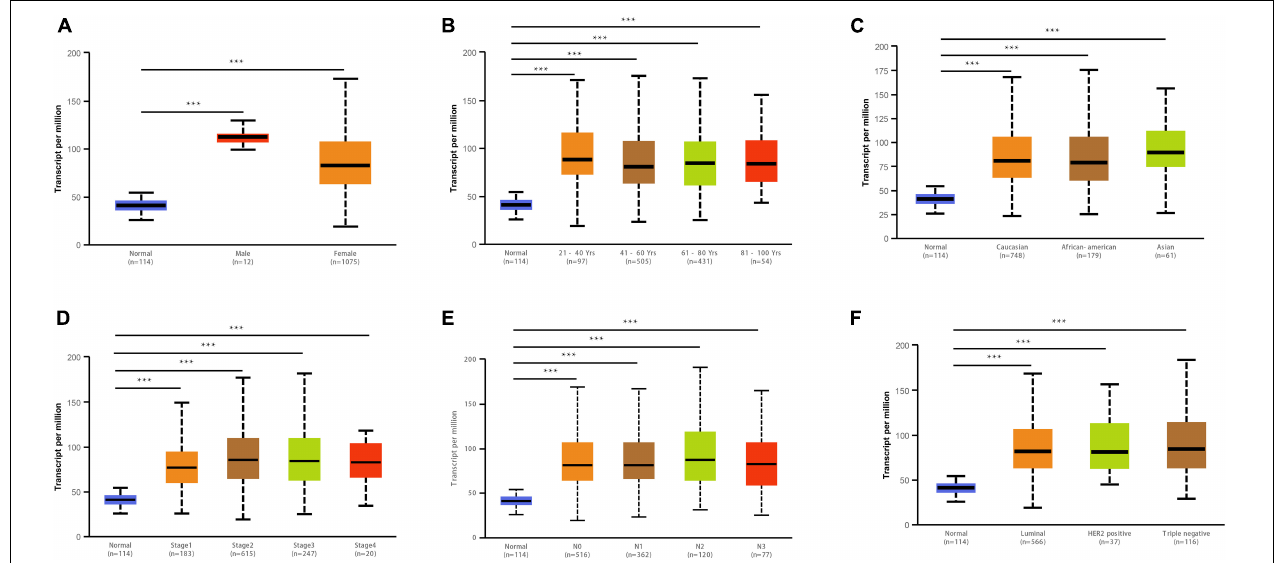
FIGURE 3 | TIMM17A transcription in breast cancer (BRCA) patient subgroups stratified by sex, age, ethnicity, cancer stage, and metastasis (UALCAN). (A) Boxplot showing relative expression of TIMM17A in normal individuals of either sex and separately for male and female BRCA patients. (B) Boxplot showing relative expression of TIMM17A in normal individuals of any age and separately for BRCA patients aged 21–40, 41–60, 61–80, or 81–100 years. (C) Boxplot showing relative expression of TIMM17A in normal individuals of any ethnicity and separately for BRCA patients of Caucasian, African-American, or Asian ethnicity. (D) Boxplot showing relative expression of TIMM17A in normal individuals and separately for BRCA patients in stages 1, 2, 3, or 4. (E) Boxplot showing relative expression of TIMM17A in normal individuals and separately for BRCA patients with regional lymph node metastasis N0, N1, N2, or N3 tumors. (F) Boxplot showing relative expression of TIMM17A in normal individuals and separately for BRCA patients with regional lymph node metastasis N0, N1, N2 or N3 tumors. Data are mean ± SE. * P < 0.05; ** P < 0.01; *** P <